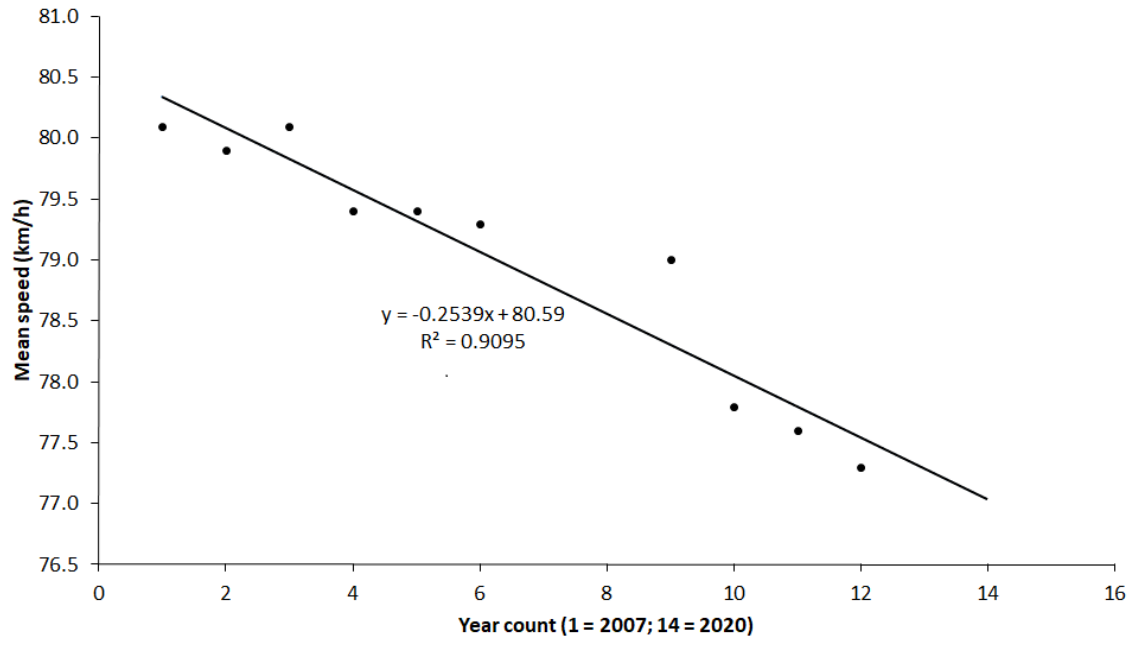
Figure 5 Change in mean speed of heavy goods vehicles from 2007 to 2020. Data for speed limit 80